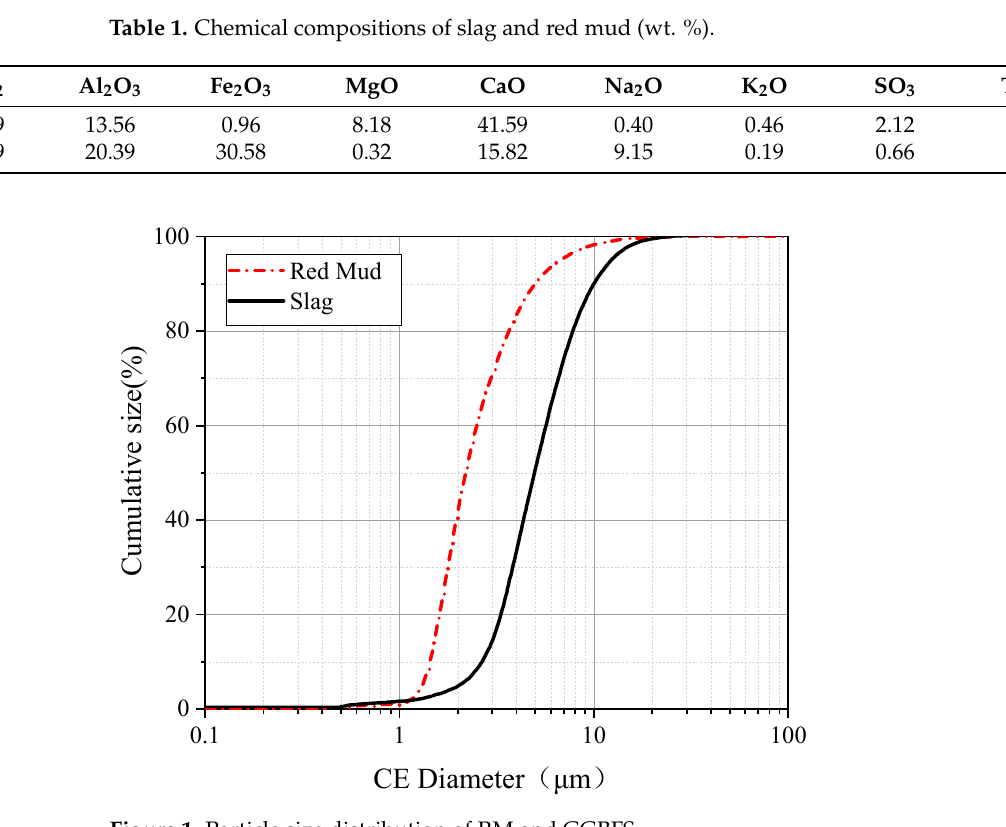
Figure 1. Particle size distribution of RM and GGBFS.